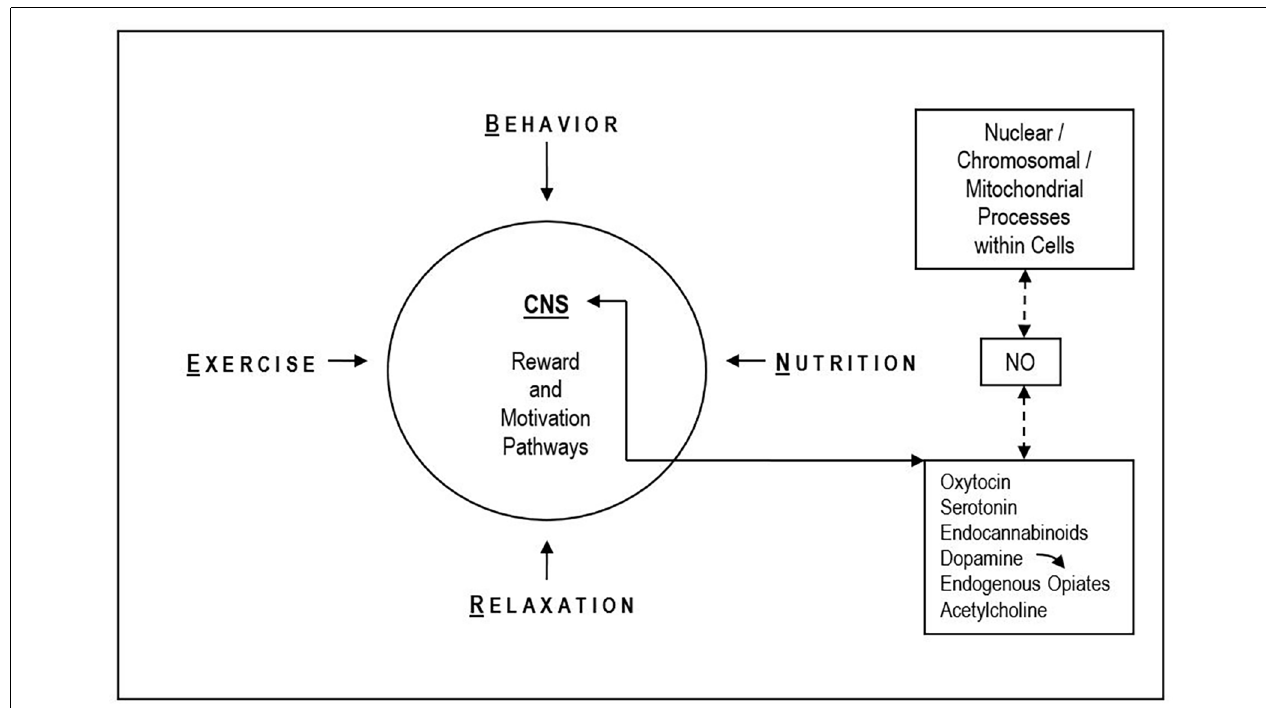
FIGURE 2 | The shared neurobiology of BERN approaches. Different BERN techniques and MBM (self-care) practices may have a direct impact on physiologic regulatory reward and motivation circuitries in the central nervous system (CNS). This commonality may represent overlapping functions associated with the general neurobiological principles of autoregulation (i.e., the potential for self-healing). MBM engages numerous CNS signaling pathways and effector molecules to promote healing, many of which converge on nitric oxide (NO) as an example for a common effector (i.e., a secondary or tertiary messenger). NO is critically coupled to the reward physiology and stress reduction/self-regulation and has a decisive impact on various processes within the cells and their organelles (i.e., chromosomes, nucleus, mitochondria). NO has also been specifically implicated in pathways leading to the placebo response (for further information and references: see text).